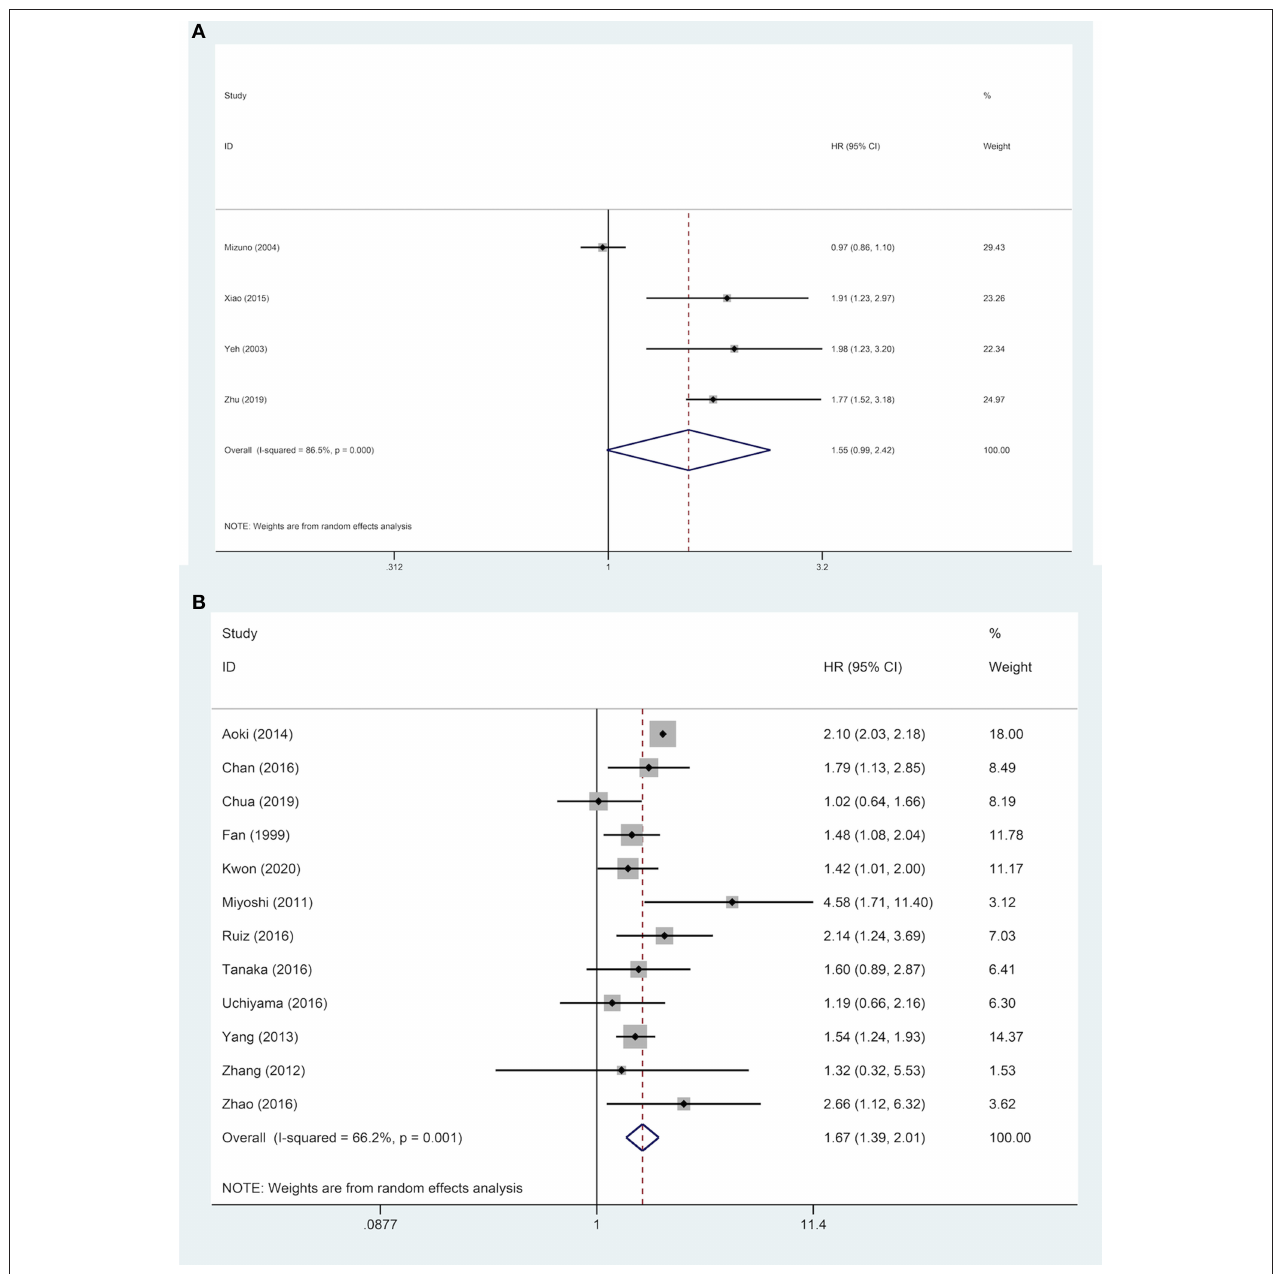
FIGURE 4 | Forest plot of OS of ruptured hepatocellular carcinoma (HCC) patients with macrovascular invasion after hepatectomy ( A , macrovascular invasion positive, P = 0.055; B , macrovascular invasion negative, P <